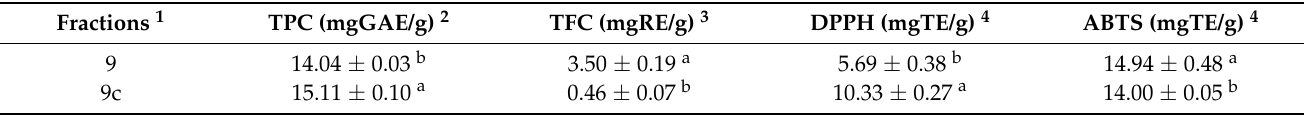
Table 5. Summary of antioxidant activity of fractions 9 and